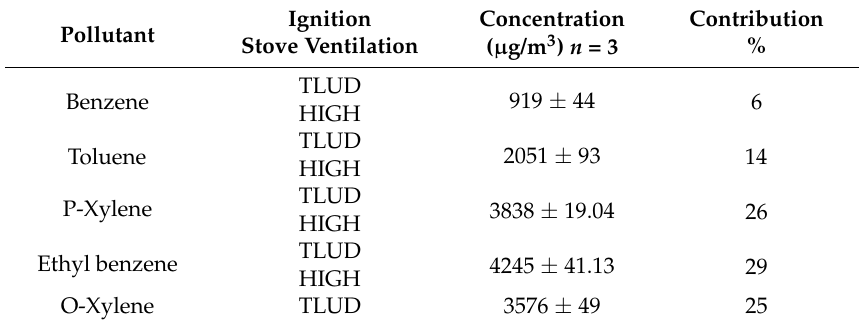
Table 4. Percentage contribution of each BTEX pollutant, averaged over a 3-h burn cycle ignited in a high ventilated stove (HIGH) and ignited using the top-lit updraft method (TLUD). Ignition Pollutant